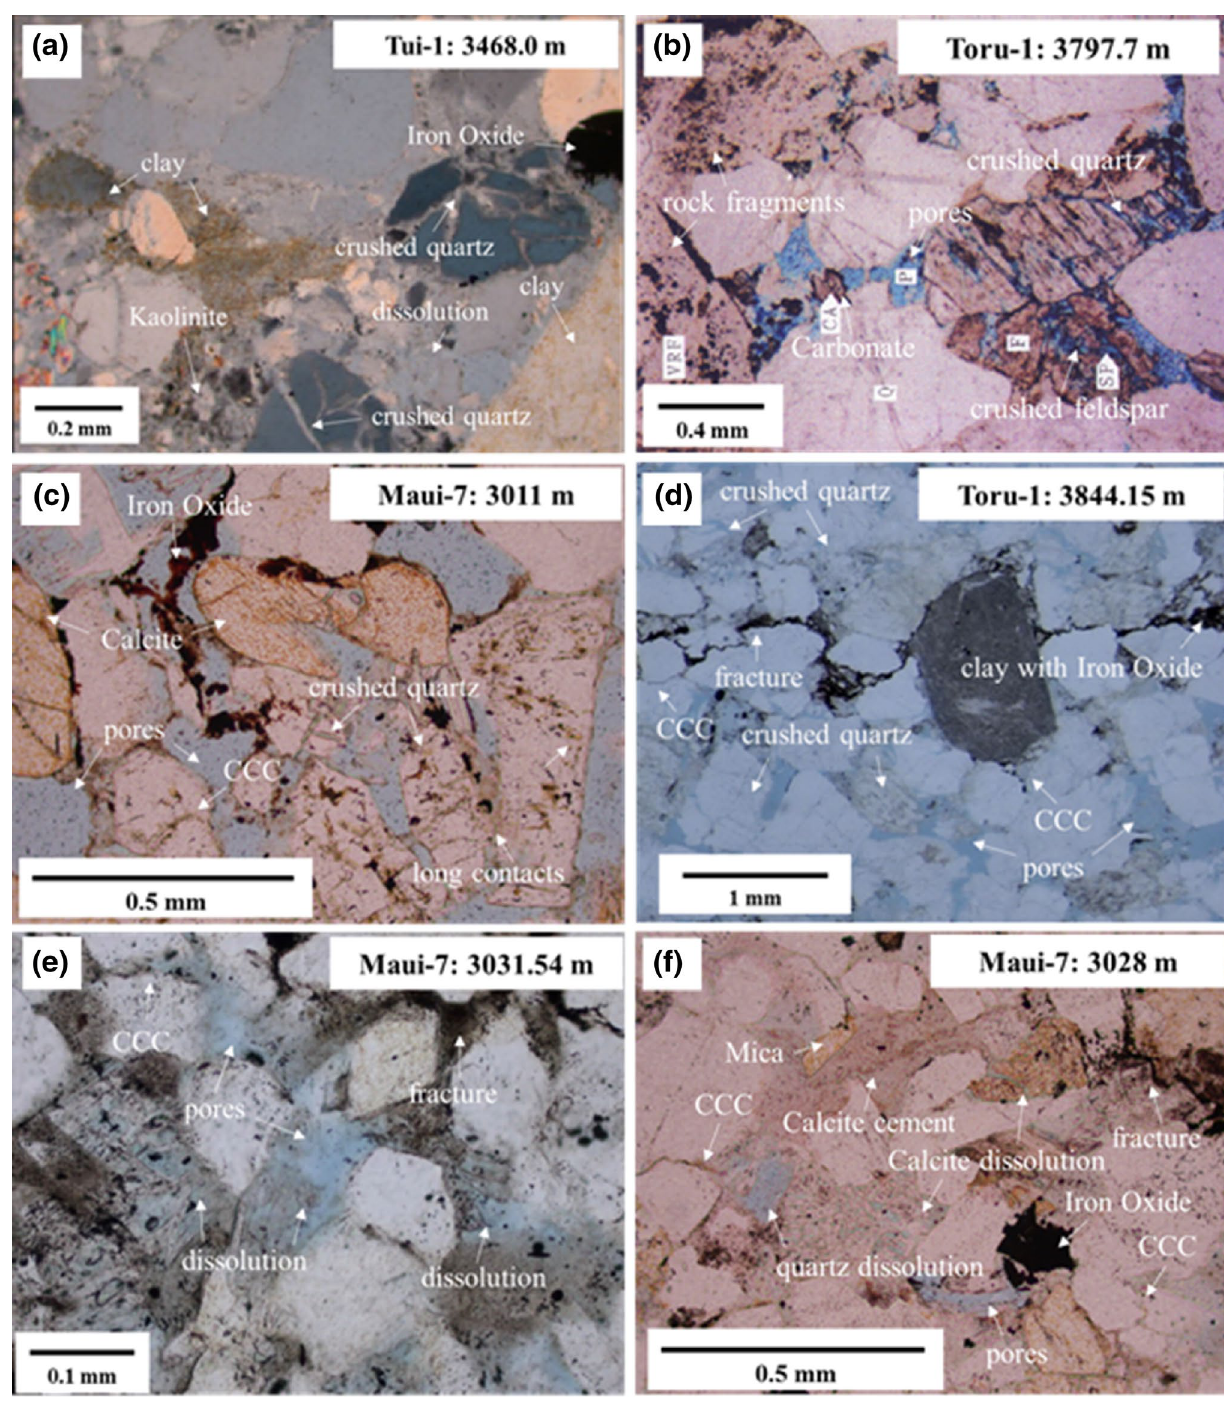
Fig. 6 Thin section photomicrographs of medium- to fine-grained Kaimiro sandstone. The main features observed in a – e are the pri- mary intergranular pores (stained blue) and secondary pores (SP) caused by diagenetic features. Other features observed in the selected sample data: a crushed quartz, quartz dissolution, the presence of kaolinite and pore filling clay; b crushed quartz and feldspar, the presence of rock fragments and carbonate; c crushed quartz, long